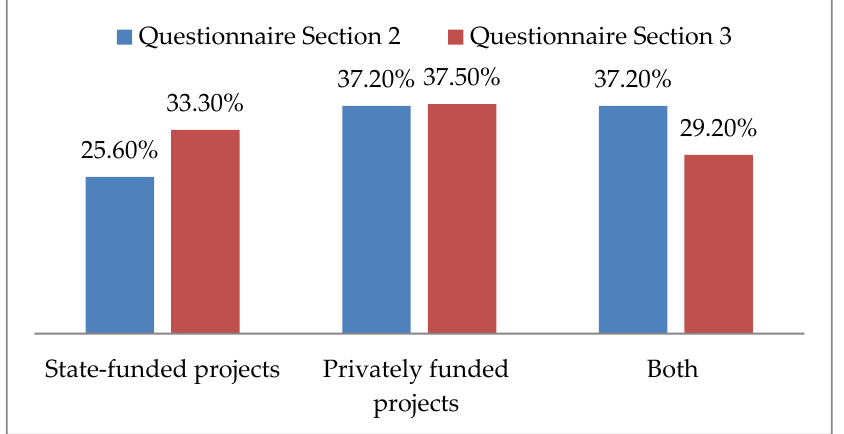
Figure 4. Processed results of Section 1 of the questionnaire. The question “Types of projects implemented by the experts”.